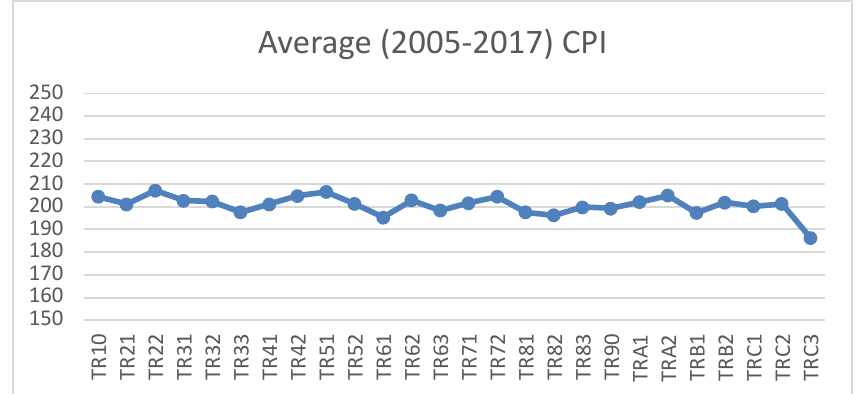
Figure 1: Average CPI